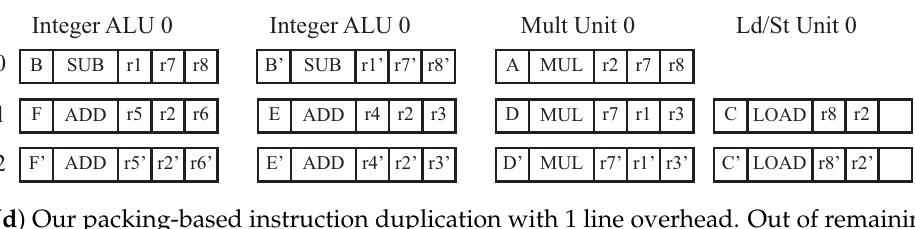
Figure 2. Simple scenario to show the efficacy of our packing-based duplication scheme. Within the same code line overhead (1 line), our packing-oriented scheme can duplicate 60% more